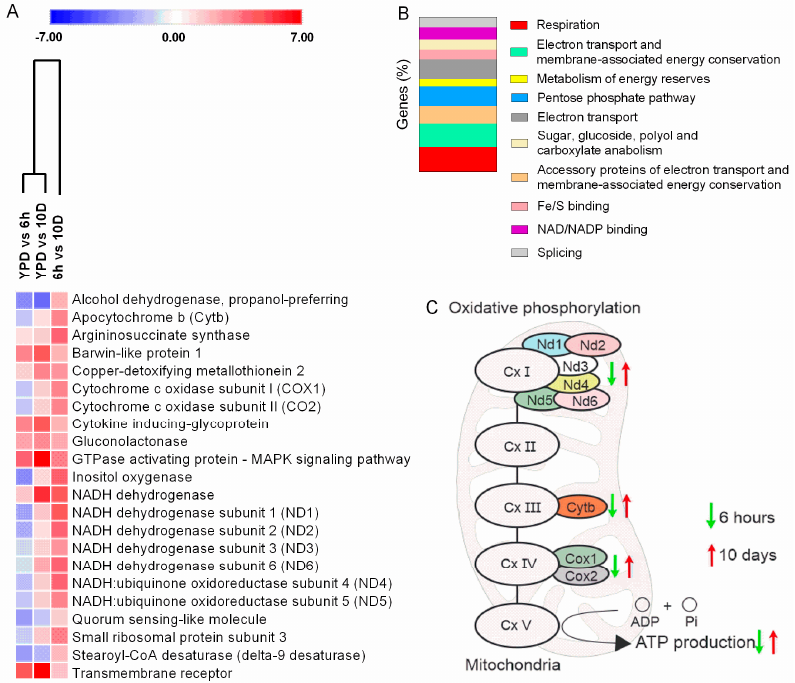
Figure 5. Transcriptional profile of C. neoformans in the bronchoalveolar space of mice. ( A ) Heatmap of the significantly enriched GO categories of regulated fungal genes at 6 h and 10 days post infec- tion. ( B ) Enriched GO biological processes of fungal genes expressed in the bronchoalveolar space. ( C ) Modulated genes from the oxidative phosphorylation pathway expressed 6 h and 10 days post infection. Upward arrows indicate induction of gene expression and downward arrows indicate repression of gene expression at 10 days, compared to 6 h. Differently regulated genes after 6 h are indicated by green arrows, and differentially regulated genes after 10 days are indicated by red arrows.